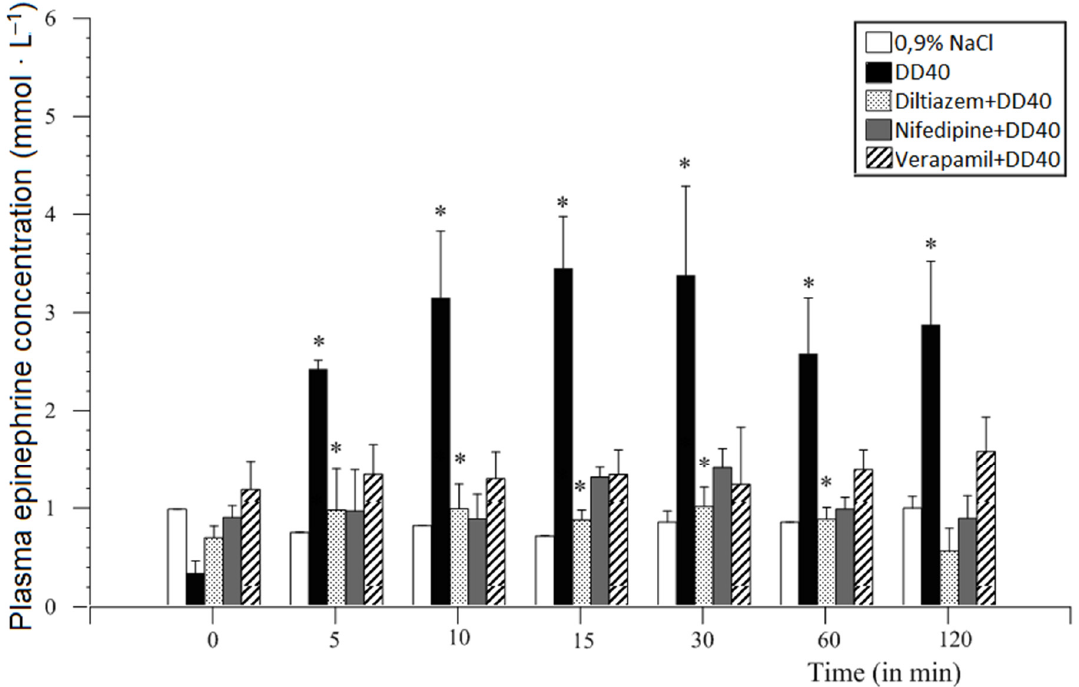
Figure 11. Comparative analysis of duodenal distension and premedication with different doses of diltiazem, nifedipine, and verapamil doses (1.0 or 2.0 mg/animal) on plasma epinephrine concentration in comparison with DD40 (mean ± SEM, n = 6, p ≤ 0.001–0.05). Mean values of results obtained from the same blood collection (time point). Significant differences are marked with asterisks [34,50].